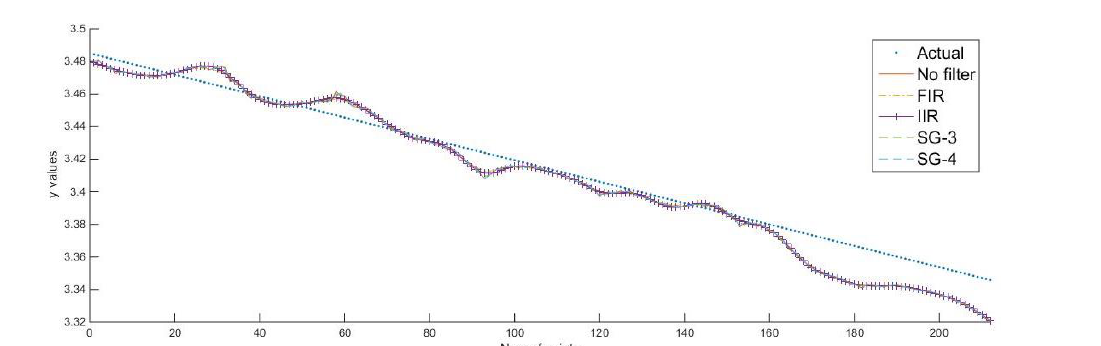
Figure 4. Illustration of Kinect output projections compared to actual points of trajectory No 4. The effect of all four applied filters, on projection, is demonstrated. Measured distances for y values are meters